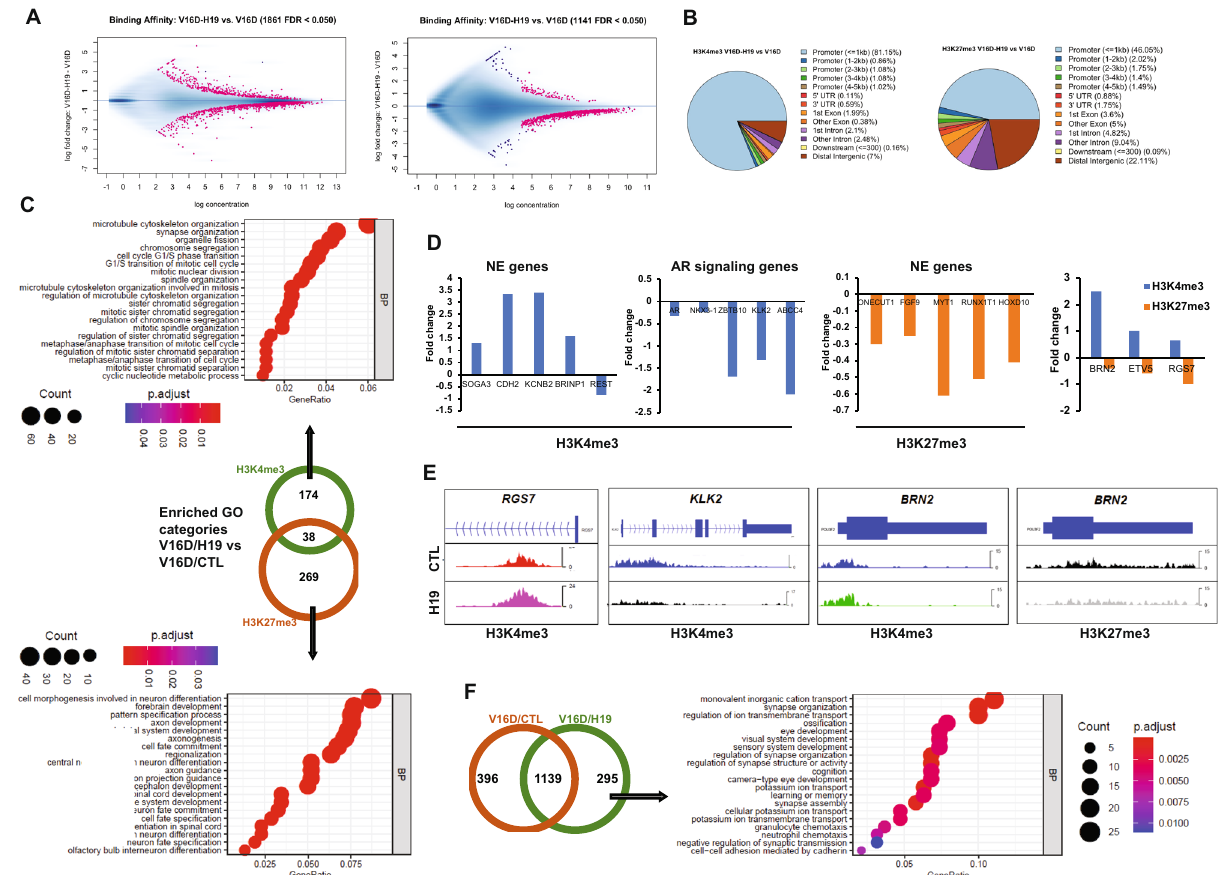
Fig. 7 H19 reprograms the chromatin landscape of NEPC and AR signaling genes by altering the histone marks for H3K27me3 and H3K4me3. A Binding af fi nity for signi fi cantly differentially bound sites (the fi rst number in the parenthesis) in V16D/H19 vs. V16D/CTL cells. (Left: H3K4me3 mark, and right: H3K27me3 mark). B Distribution of proximal genomic features for signi fi cantly differentially bound sites in V16D/H19 vs. V16D/CTL cells for H3K4me3 and H3K27me3 histone marks. C Venn diagram (Center) of enriched GO categories from the differential binding results of V16D/H19 vs. V16D/ CTL comparison for H3K4me3 and H3K27me3 histone marks. Arrows lead to dot plots with top 20 signi fi cantly enriched GO categories (pAdjustMethod = “ BH ” , p -value Cutoff = 0.05, q valueCutoff = 0.05) for Biological Processes (BP) for H3K27me3 (bottom) and H3K4me3 (top). D Plot of representative genes in NE and AR signaling categories have signi fi cant differential binding (fold change) in V16D/H19 vs. V16D/CTL for H3K27me3 and H3K4me3 marks in regions proximal to or within their gene bodies. E Representative examples of ChIP-seq tracks for indicated genes and histone marks in V16D/H19 (H19) vs. V16D/CTL (CTL). F Venn diagram showing the overlap of bivalent sites from V16D/H19 and V16D/CTL. The right panel shows GO analysis (BP category) of the 295 bivalent sites enriched speci fi cally for V16D/H19 only. In C and F , dot size indicates count. A – F Differential binding analysis data are collected from n = 3 independent biological